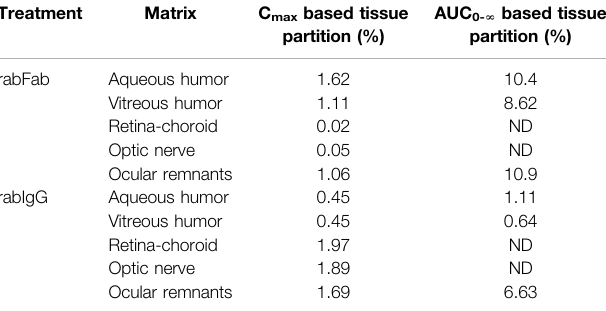
TABLE 2 | Relative percent ocular tissue:serum partition (C max and AUC 0- ∞ based) of rabFab and rabIgG following a single intravenous bolus dose of 125 I-rabFabor 125 I-rabIgG(radiolabeledmixedwithunlabeled,total1 mgdose)in male New Zealand White